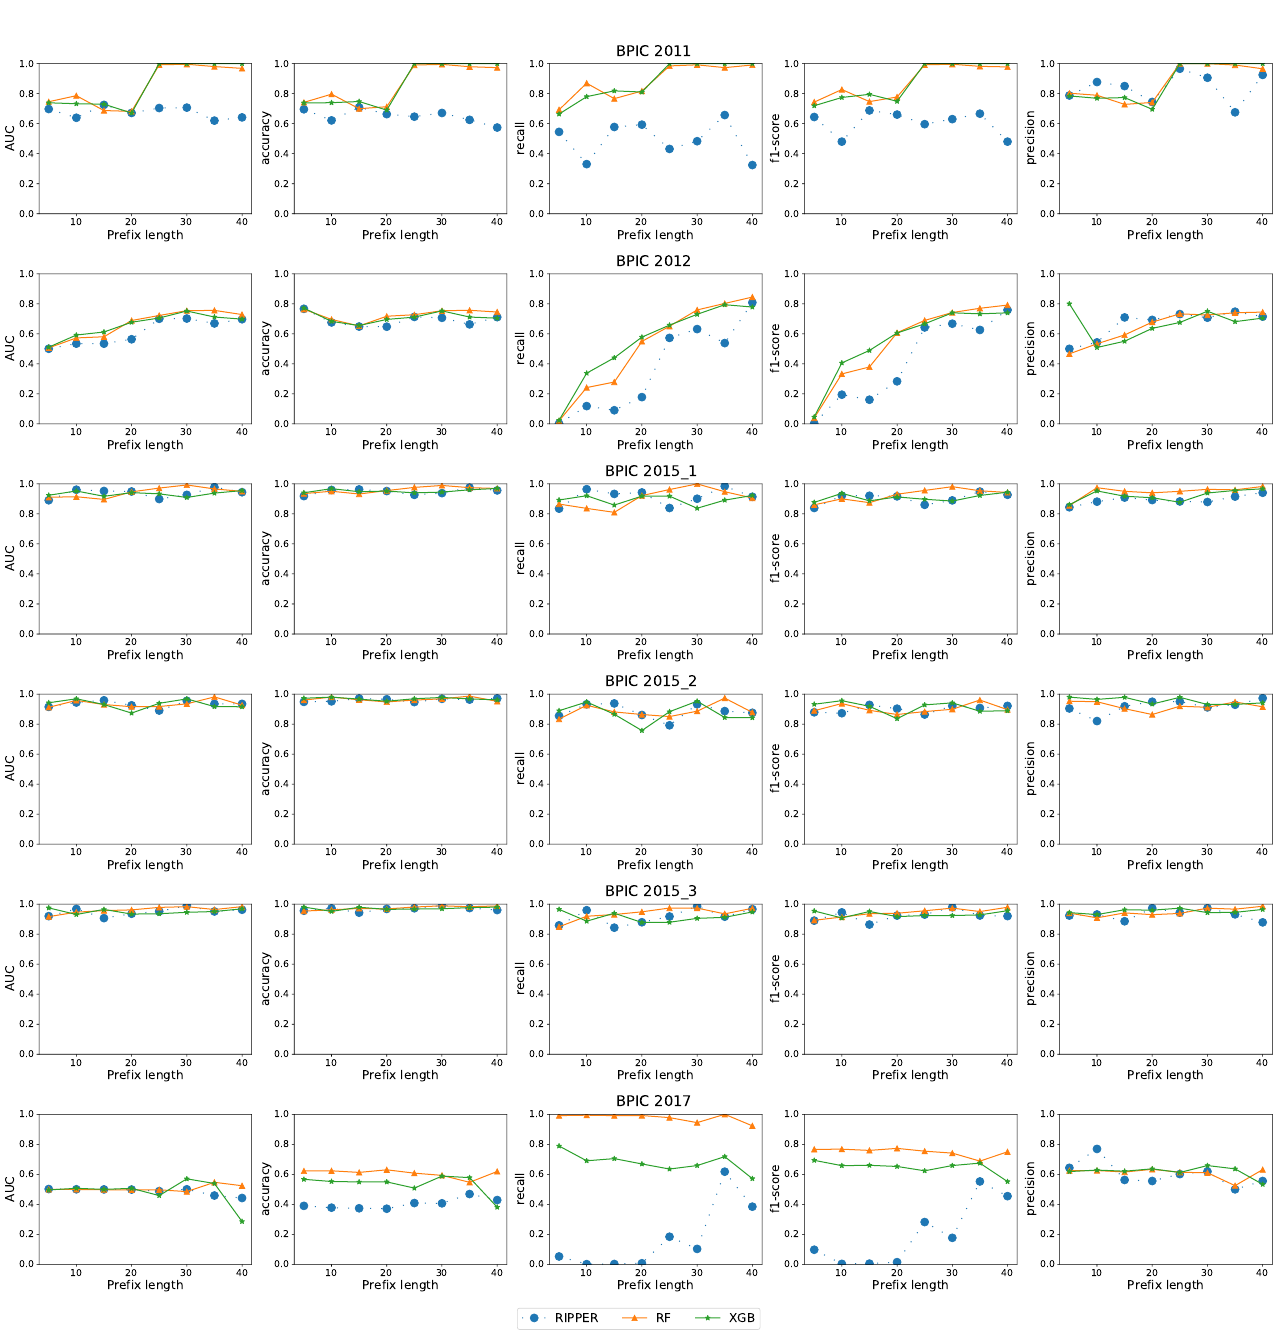
Figure 2. Predictive performance of RIPPER against ML-based